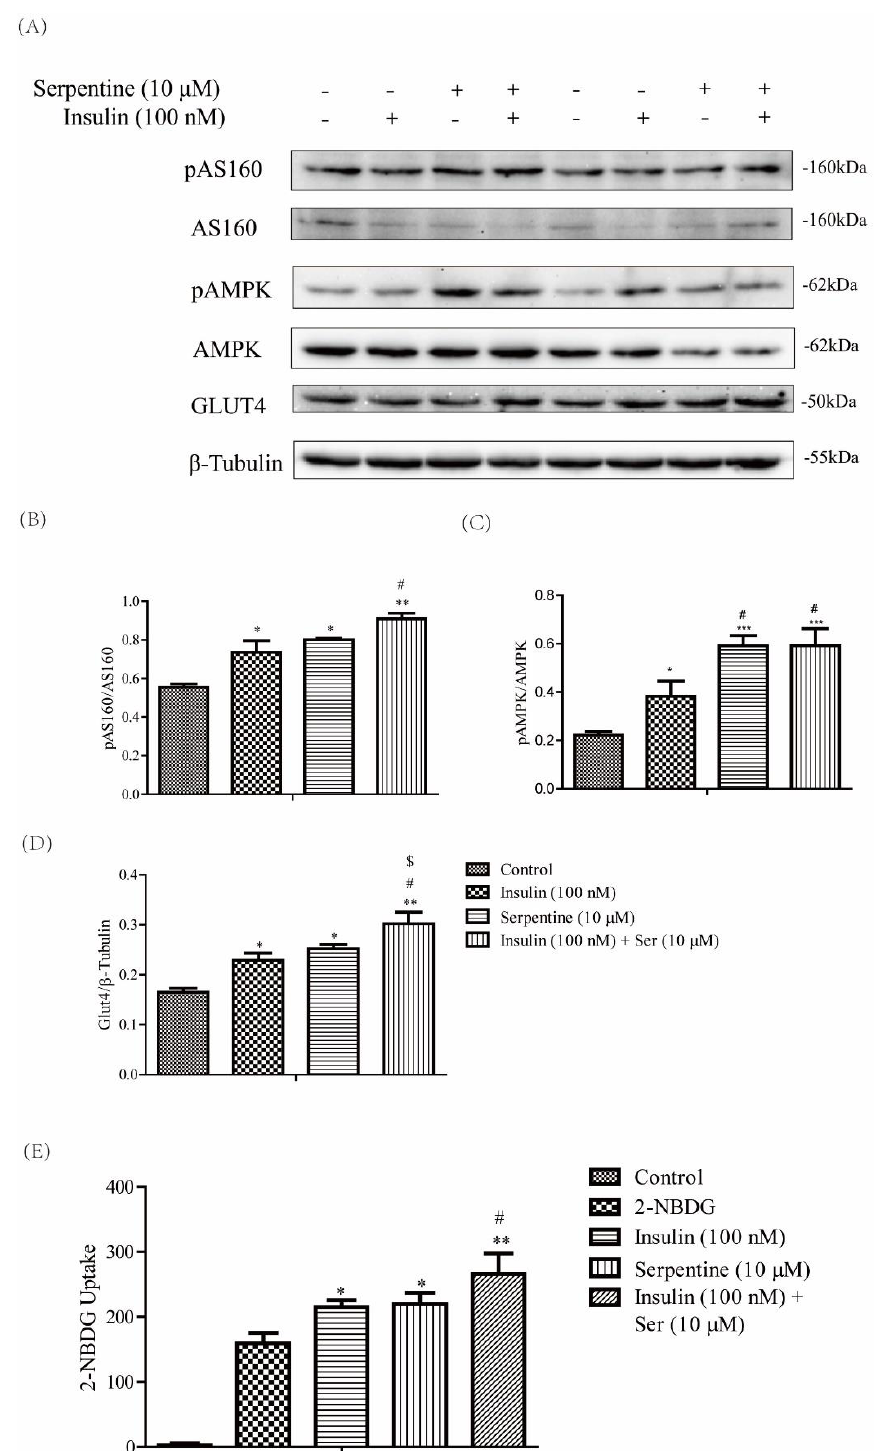
Figure 6. Serpentine promotes glucose uptake through AMPK signaling. ( A ) Expression of key pro-teins of the AMPK-induced glucose uptake pathway in C2C12 cells after treatment with insulin (100 nM) and serpentine (10 µ M). ( B ) pAS160/AS160, ( C ) pAMPK/AMPK, ( D ) Glut4/ β -tubulin, and ( E ) 2-NBDG uptake in C2C12 cells treated with insulin (100 nM) and serpentine (10 µ M). Data are ex-pressed as mean ± SEM ( n = 4 per group). * p < 0.05, ** p < 0.01, *** p < 0.001 versus control; # p < 0.05 versus insulin (100 nM); $ p < 0.05 versus serpentine (10 µM).